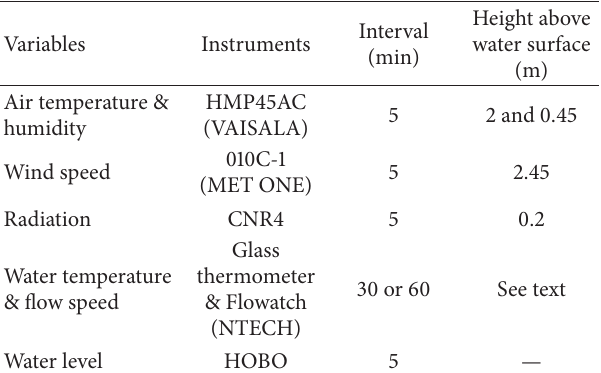
Table 1: General descriptions of the instruments installed at station